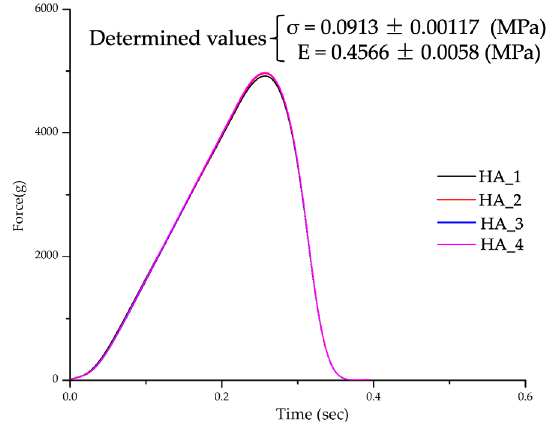
Figure A7. The results of the mechanical assay, displayed by the device used (TA - XT2 Plus) for the prepared beads .